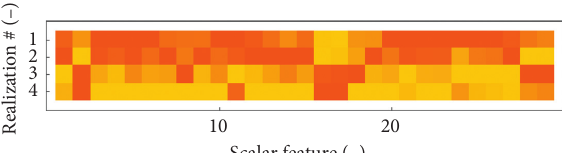
Figure 4: Comparison of data vectors from ´Ust´ı nad Orlic´ı (rows 1 and 2) and Choceˇn (rows 3 and